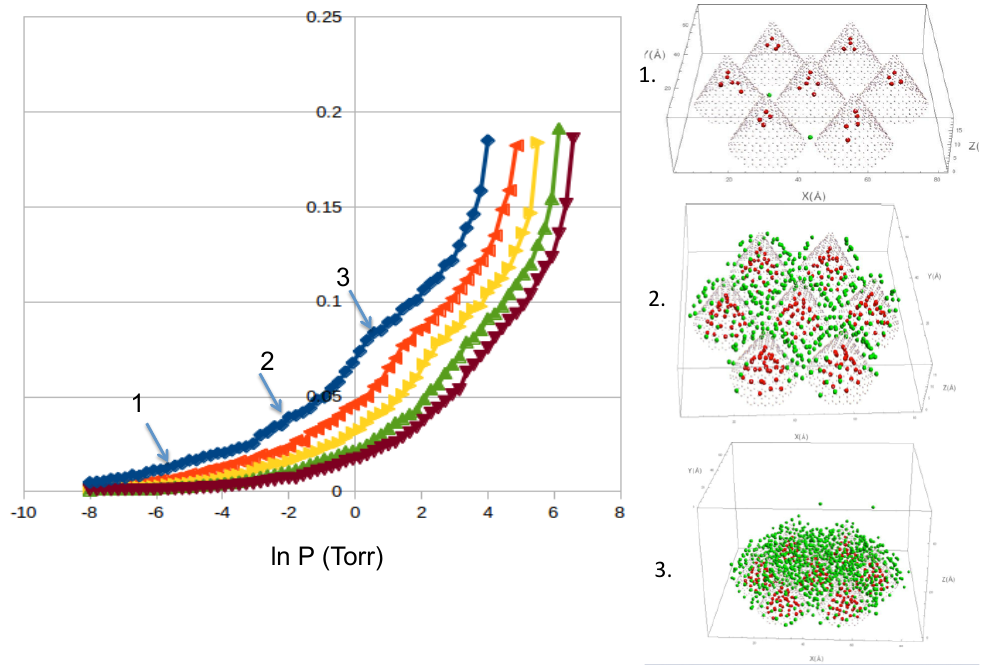
Figure 5. Adsorption isotherms of argon (in Å − 2 ), at temperatures of 70.32, 81.51, 86.45 and 91.13 K (from left to right). Also shown are configurations at low ( 1 ); medium ( 2 ) and high ( 3 ) coverage, as labeled. Color code: atoms inside the cones (red) and outside (green).